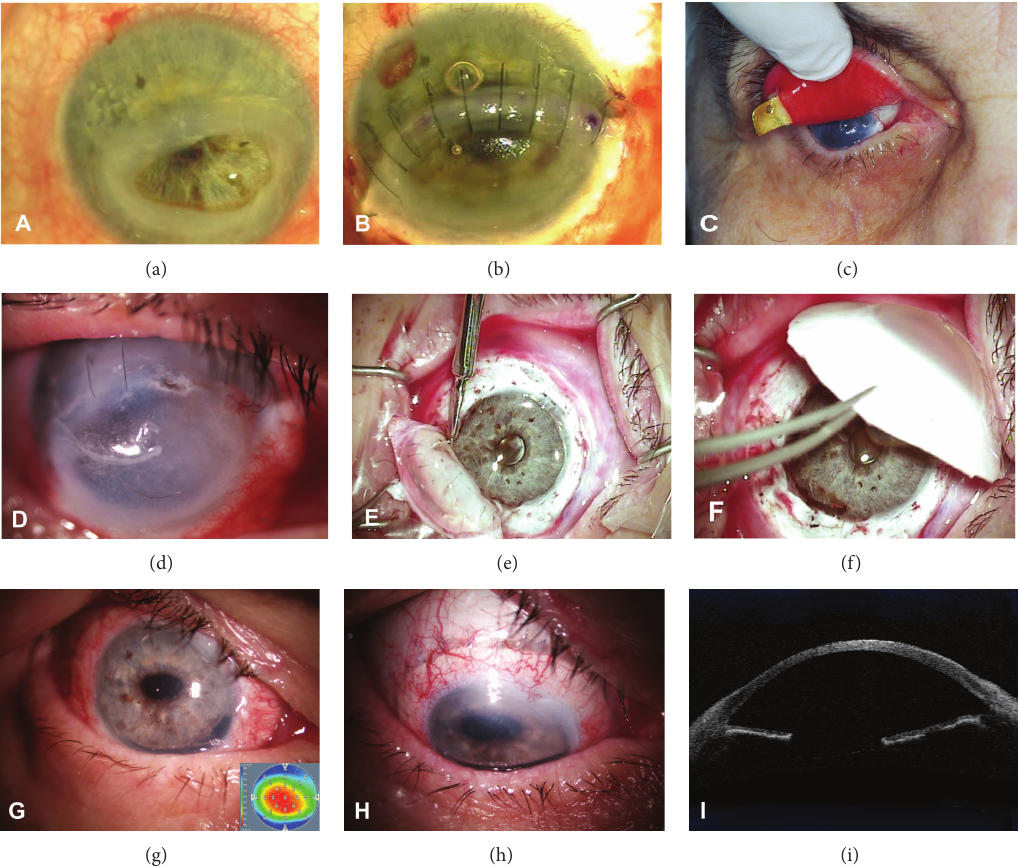
Figure 1: The anterior segment of the eye 12 months after sclerokeratoplasty on 360 degrees: pre- and postoperative picture and the surgical technique. (a) Corneal perforation (b) inferiorly decentred penetrating keratoplasty; (c) extrusion of the gold weight from the right upper eyelid; (d) graft rejection; (e) sclerokeratectomy (preparation of the cornea); (f) sclerokeratectomy (graft adaptation); (g) anterior segment of the eye and pachymetry map 12 months after surgery; (h) donor graft fitting 12 months after surgery; (i) anterior segment of the eye 12 months after the surgery